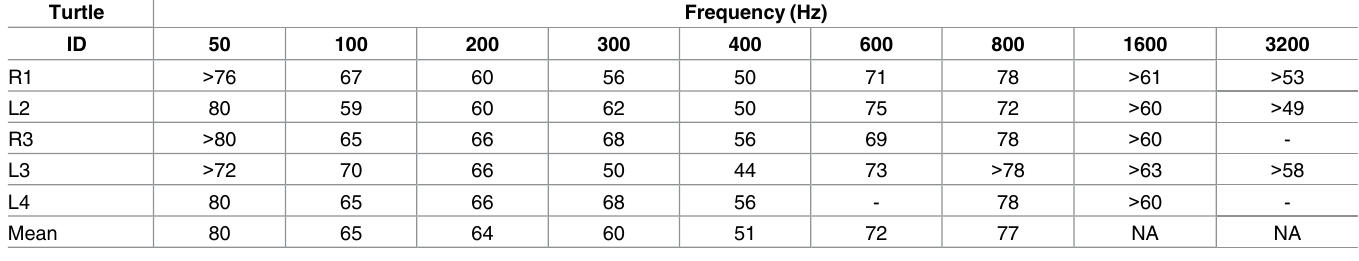
Table 2. Aerial pressure thresholds (dB re: 20 μ Pa-rms)for individual juvenile green sea turtles ( Chelonia mydas ), and mean thresholds for all turtles combined. Frequenciestested with no detected auditory evoked potential response are presented with > “highest sound pressure level presented” (dB re: 1 μ Pa-rms).